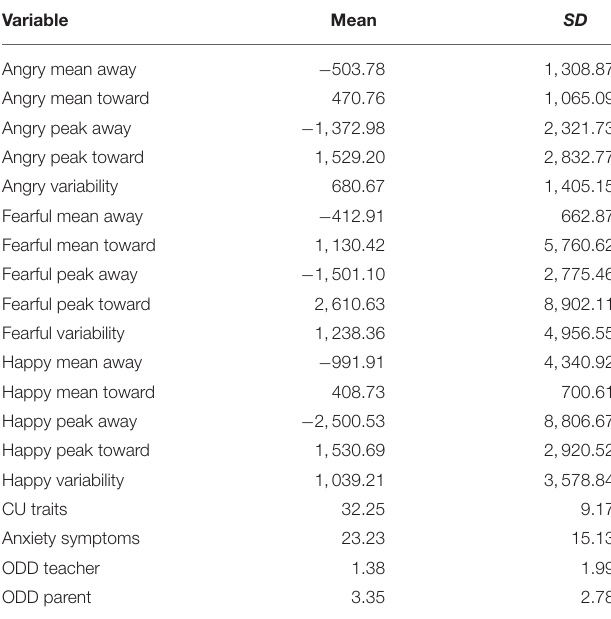
TABLE 1 | Descriptive statistics for TL-BS parameters for each emotional face, CU traits, anxiety and ODD-related problems.